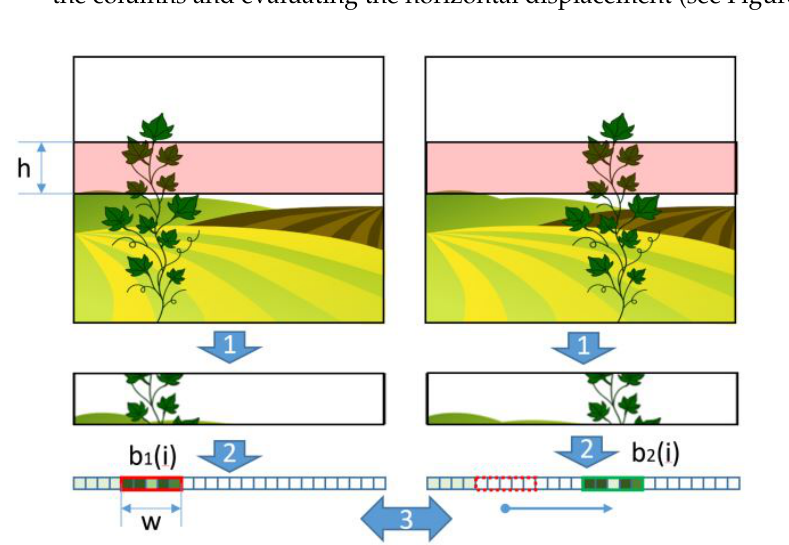
Figure 12. Matching between projections: 1, band extraction, 2, projection computing, 3, best- matching